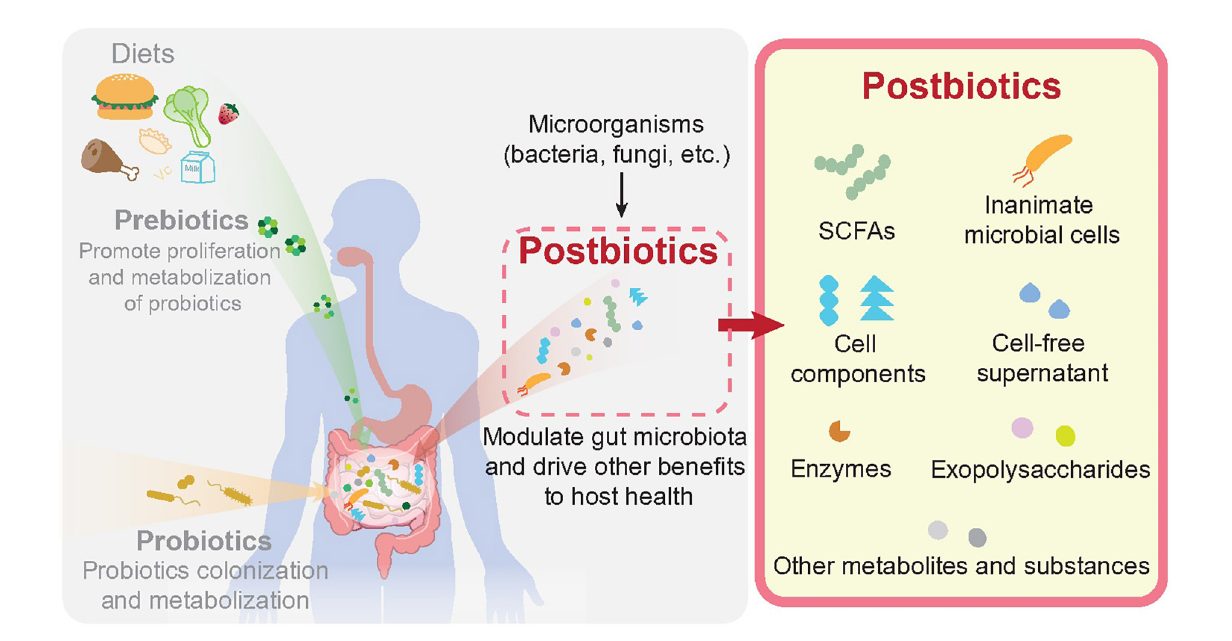
FIGURE1 Prebiotics, probiotics, and postbiotics in human gut. As described in the main text, prebiotics are produced through consumption of daily intakes by our digest system, which are selectively utilized by host microorganisms conferring health benefits. Probiotics are defined as live microorganisms residing in human body, notably the intestinal lumen, which are beneficial for human health. Postbiotics are preparations of microbial derived substances that contribute to the health of host. Postbiotics can be derived from variable microbial origins, including cell components, cell-free supernatants, cell wall structures like exopolysaccharides (EPS), metabolites like short chain fatty acids as well as enzymes